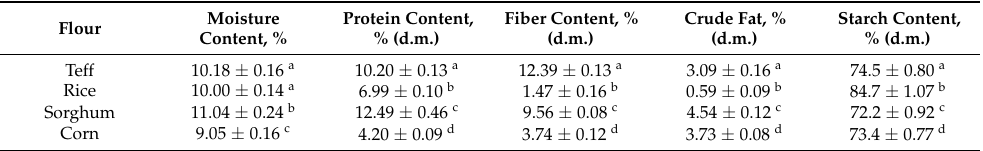
Table 4. Chemical composition of the nongluten flours. Flour Moisture Content, % Protein Content, % (d.m.) Fiber Content, % (d.m.) Crude Fat, % (d.m.) Starch Content, %